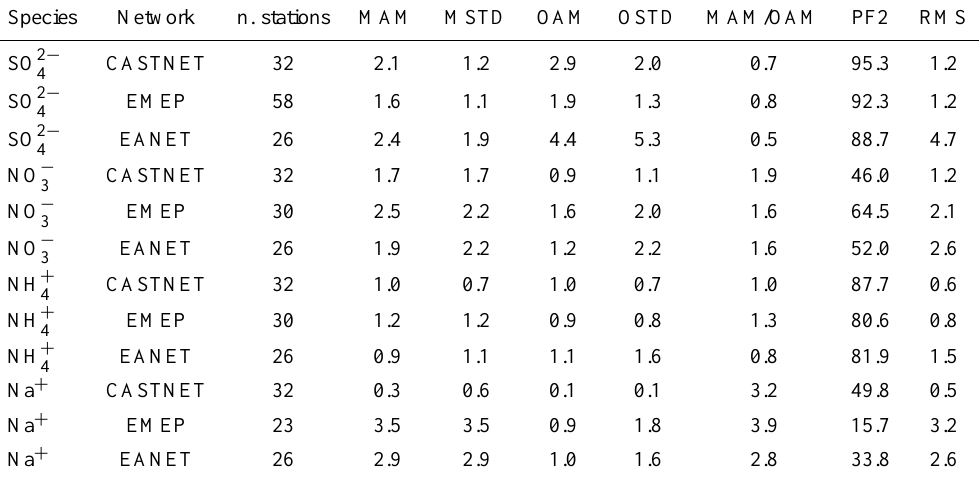
Table 3. Summary of the comparison of model results to observations of aerosol concentrations. OAM and MAM are the arithmetic mean of the observations and of the model, respectively (in µgm − 3 ), while OSTD and MSTD are the standard deviation of the observations and of the model, respectively (in µgm − 3 ). MAM and MSTD were calculated by sampling the model at the locations of the observations and monthly averaged as the observations, over the 2005–2008 period. MAM, OAM, MSTD and OSTD represent co-located measurements and model results. PF2 is the percentage of modelled point within a factor of two of the observations. RMS denotes the Root Mean Square error.